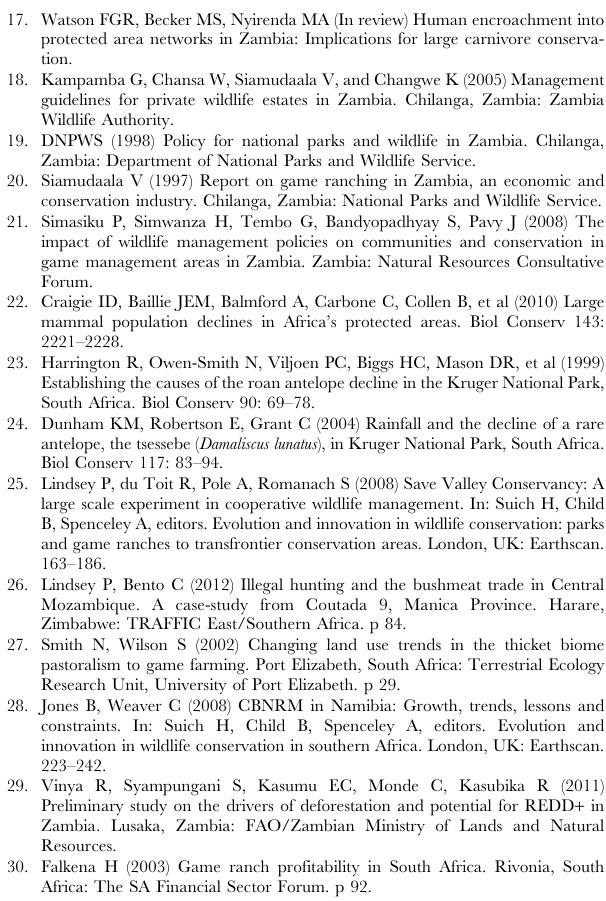
Table S1 Key assumptions applicable to the financial and economic small-scale fenced game ranch model (USD, 2012).